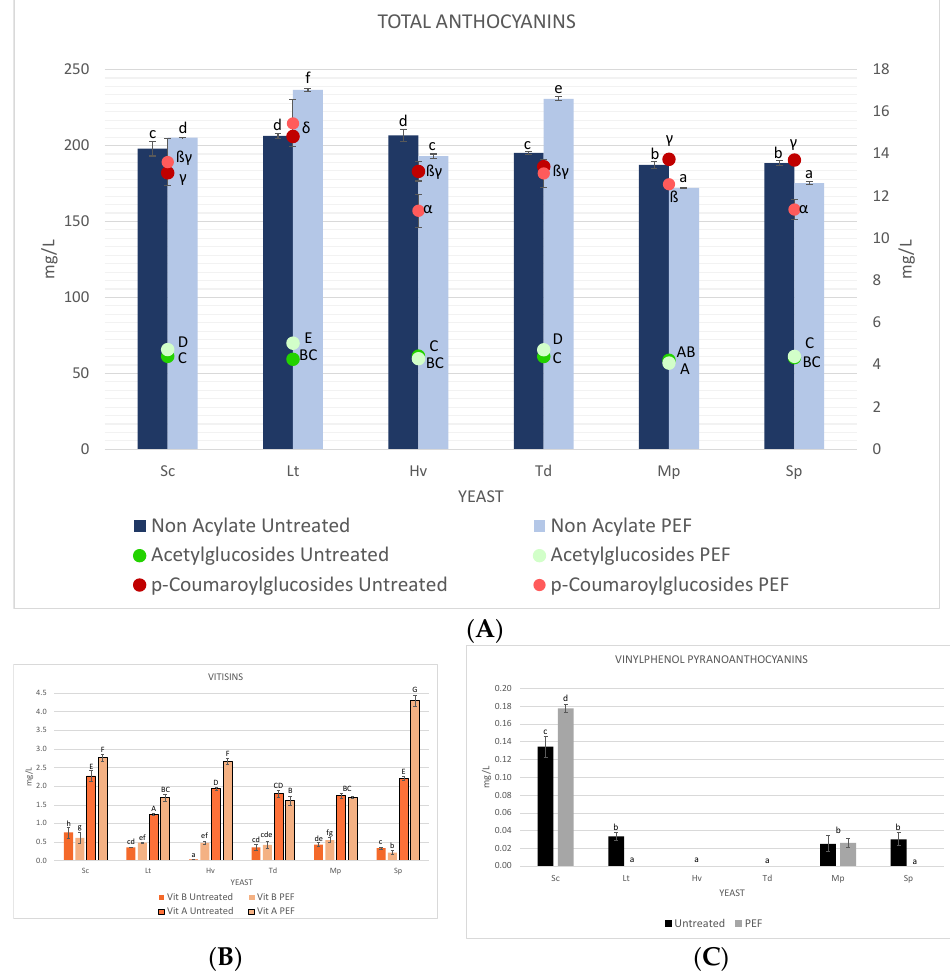
Figure 7. ( A ) Total anthocyanins divided into three groups of untreated and PEF-treated wine. ( B ) Vitisins A and B. ( C ) Vinylphenol pyranoanthocyanins. Values are means ± sd ( n = 3). A different letter (lowercase, capital and Greek letters) for the same category of anthocyanins means significant differences ( p < 0.05).